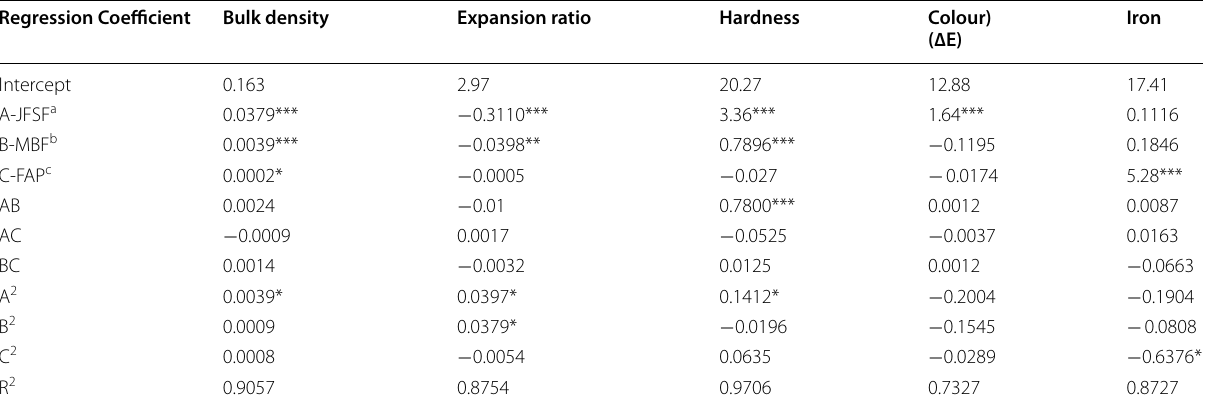
Table 3 Regression coefficients values for iron rich extruded